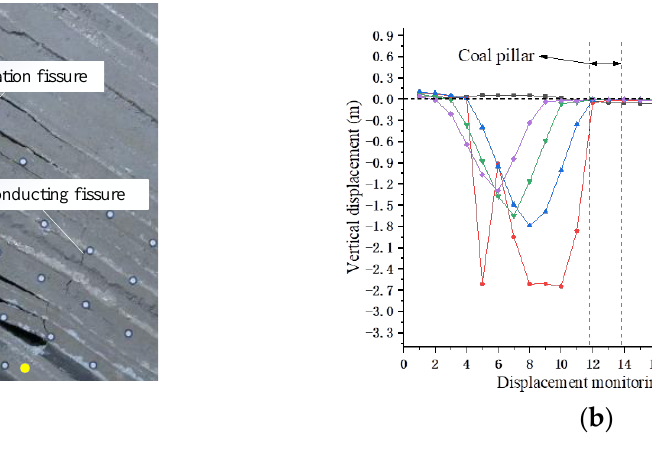
Figure 5. Migration characteristics of overburden in overhead mining. ( a ) Mining 70 m in the upward mining face; ( b ) vertical displacement of overburden in overhead mining.